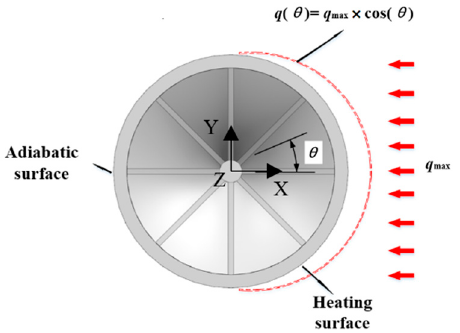
Figure 3. Distribution of the heat flux on the tube surface. Table 1. Boundary conditions.